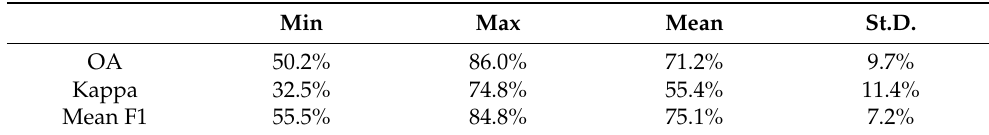
Table 10. Summary statistics for Figure S1—Variation in OA, Kappa and weighted-mean F1 for 1998–2020. Min Max Mean St.D. OA 50.2% 86.0% 71.2% Kappa 32.5% 74.8% 55.4% Mean F1 55.5% 84.8%